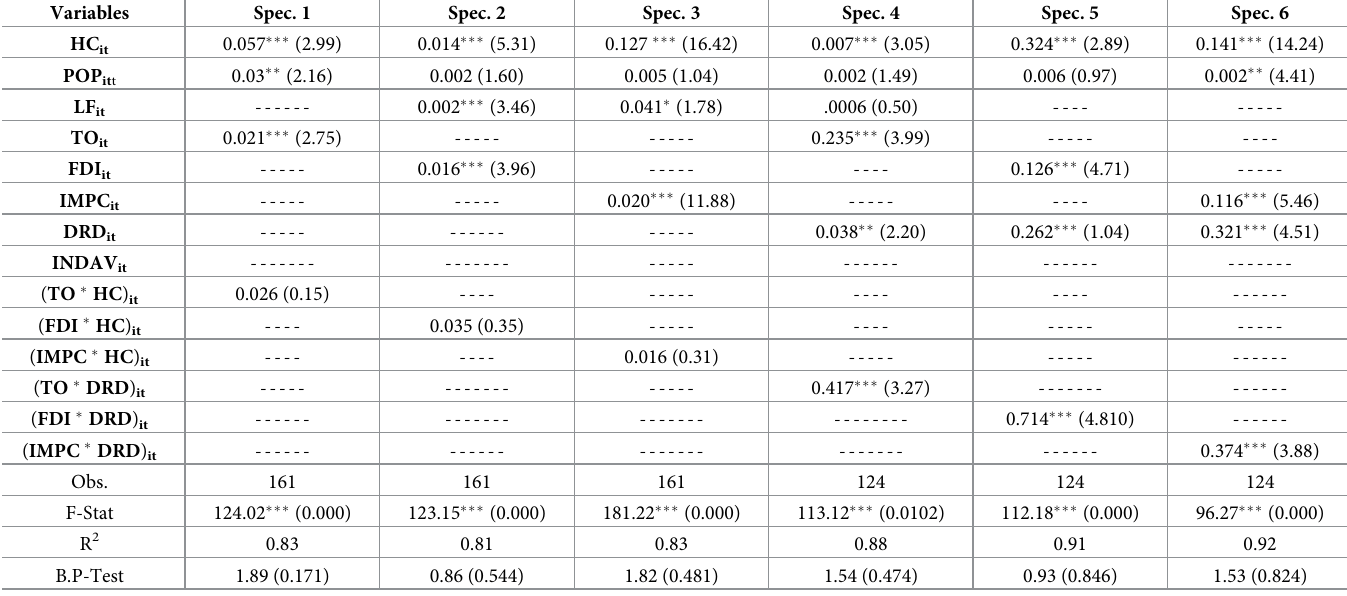
Table 2. Estimated results (dependent variable is